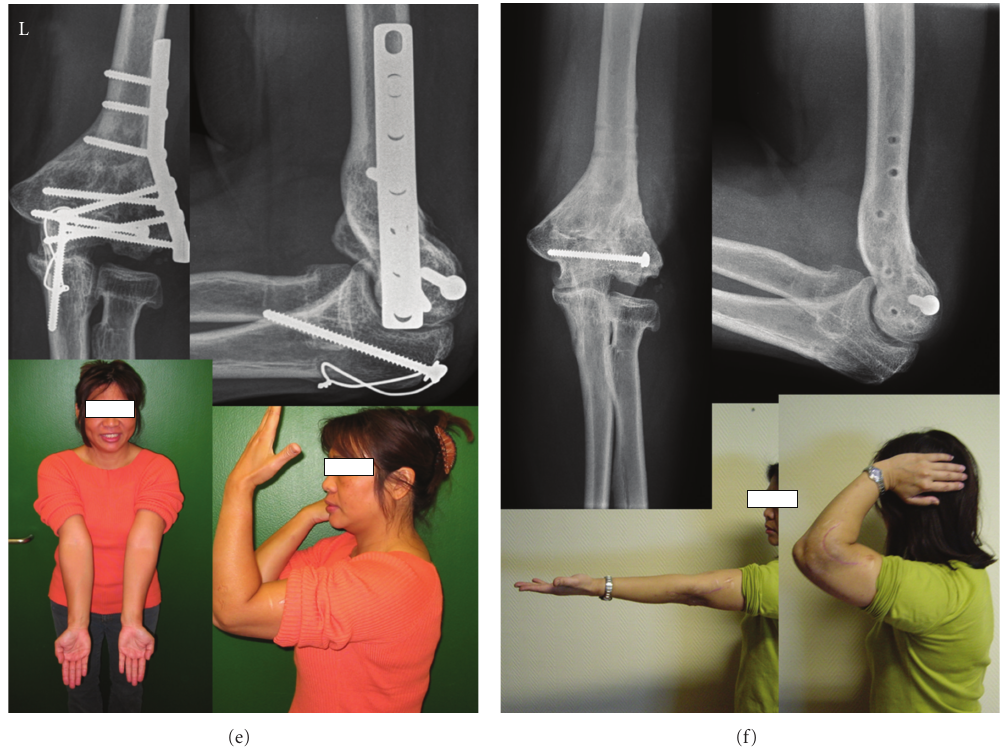
Figure 1: (a) Our patient was a 48-year-old dentist who was seen 10 months after a high energy fall that resulted in a complex intra- articular fracture of her left nondominant distal humerus. (b) Initial treatment performed at an outside institution consisted of static external fixation with the arm in 90 ◦ flexion and the forearm in neutral rotation. (c) The external fixator was removed after 8 weeks and follow-up the radiographs revealed distal humerus intra-articular malunion. (d) An oscillating saw was used to create a trapezoid wedge to correct overlength varus of the lateral column and flexion of the capitellum in order to realign capitellum and trochlea. Extreme caution was taken no to disrupt blood supply of the capitellum. (e) The patient had loss of anterior translation of the distal end of the humerus resulting in loss of flexion of 35 degrees, with 10 degrees of hyperextension of the left elbow. (f) Patient opted for removal of hardware and extra-articular excavation of the prominent ventral distal humerus creating a new fossa coronoidea in order to gain